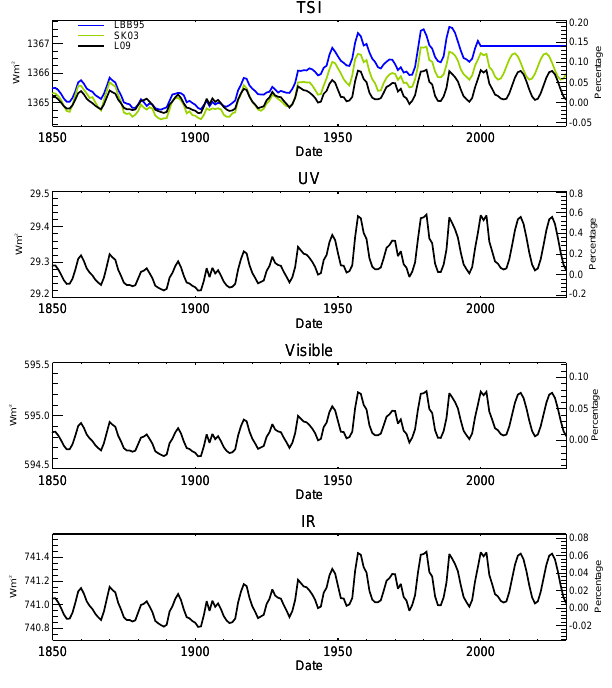
Fig. 13. Annual mean solar irradiance variations used in the historic model simulation (L09 - Lean et al., 2009). (a) Total solar irradi- ance. Also shown are the TSI used in previous model simulations, LBB95 (Lean et al., 1995b) used in HadCM3 (Stott et al., 2000) and SK03 (Solanki and Krivova, 2003) used in HadGEM1 (Stott et al., 2006). Solar irradiance averaged over (b) the ultraviolet band (200– 320nm), (c) the two visible bands (320–690nm), and (d) infrared bands (690–1190, 1190–2380, and 2380–10000nm). Percentages are given with respect to the solar constant (1365Wm − 2 ) , and as- sociated distribution across the shortwave spectral bands.